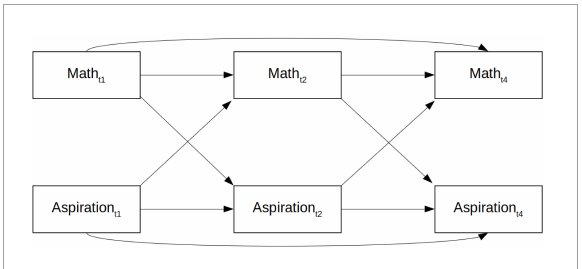
FIGURE1 Theoretical model. Source: own design. No measurements are available for t3, which is hence